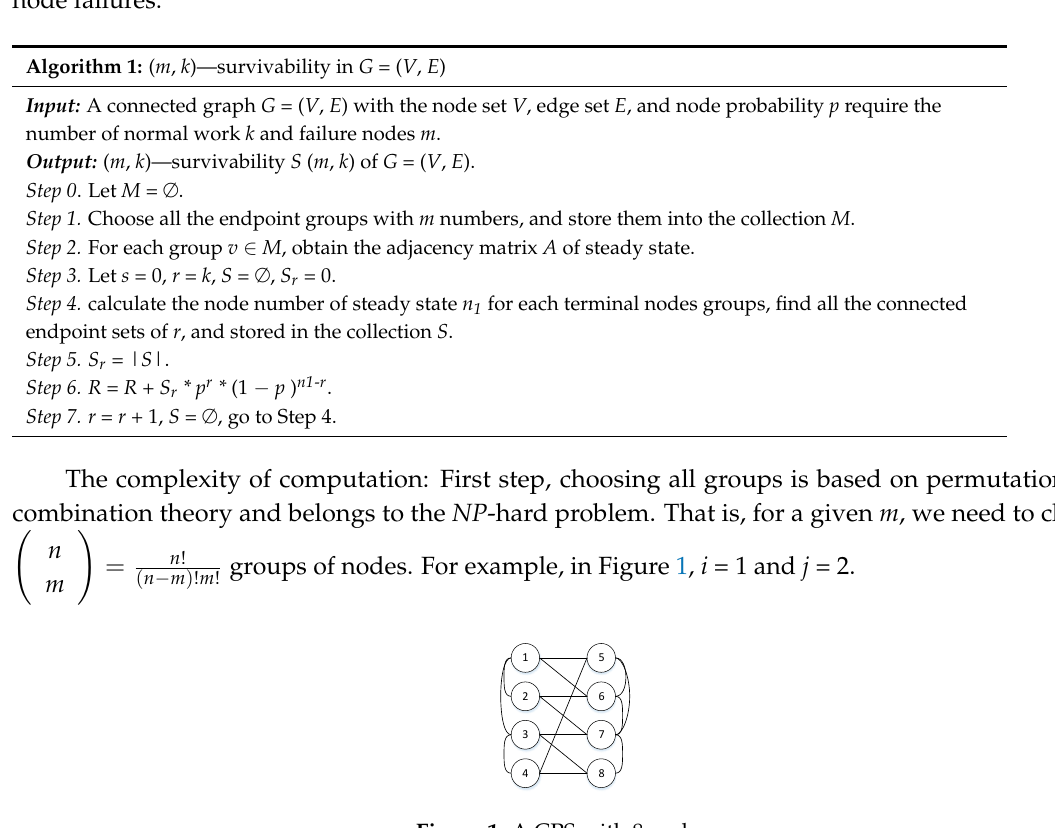
Figure 1. A CPS with 8 nodes.